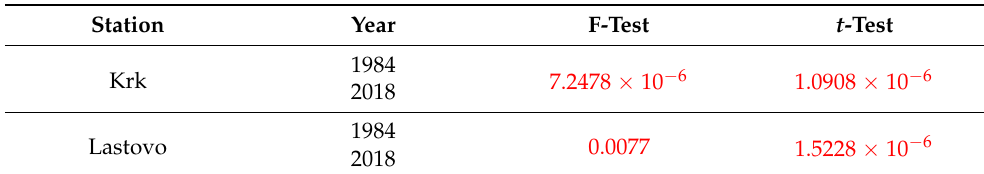
Figure 6. Time series of the mean daily air temperatures at Lastovo (brown) and Krk (blue) and a series of their differences (red) observed in 1984 ( A ) and 2018 ( B ). Table 3. Results of probability, p , of the F-test and t -test between mean daily air temperatures on Krk and Lastovo in 1984 and 2018 (Figure 6).